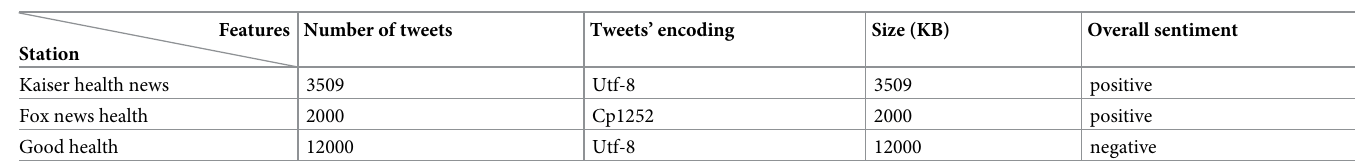
Table 3. Characteristics of three health tweets